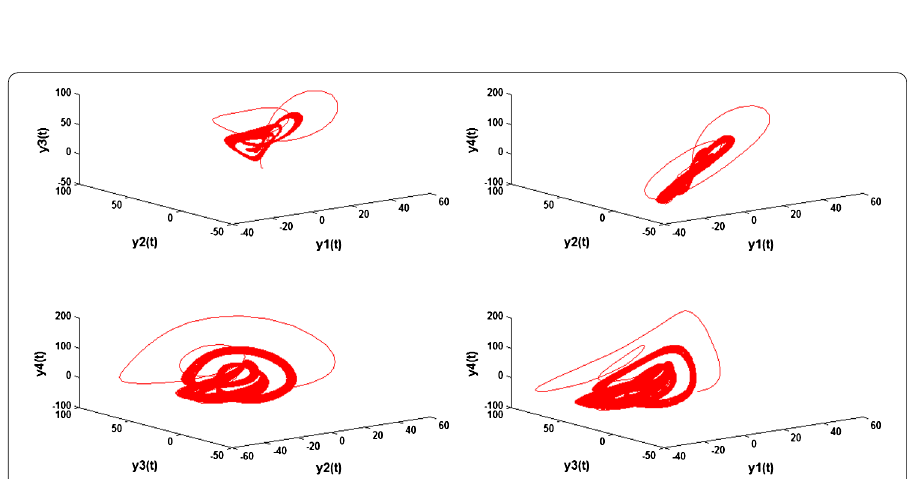
Figure 2 Different plots of the hyperchaotic attractor of the commensurate fractional Chen system (21).